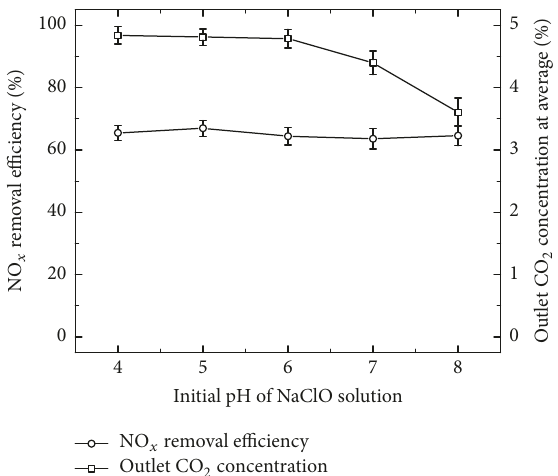
concentrations). x